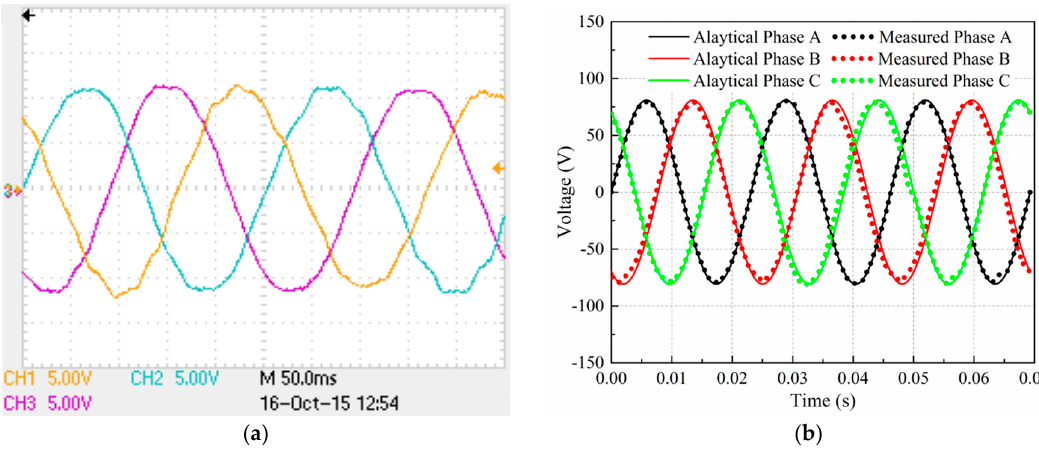
Figure 17. ( a ) Measured back EMF of the rotary motion unit at 50 r/min; and ( b ) comparison of the analytical and measured back EMF of the rotary motion unit at 520 r/min.